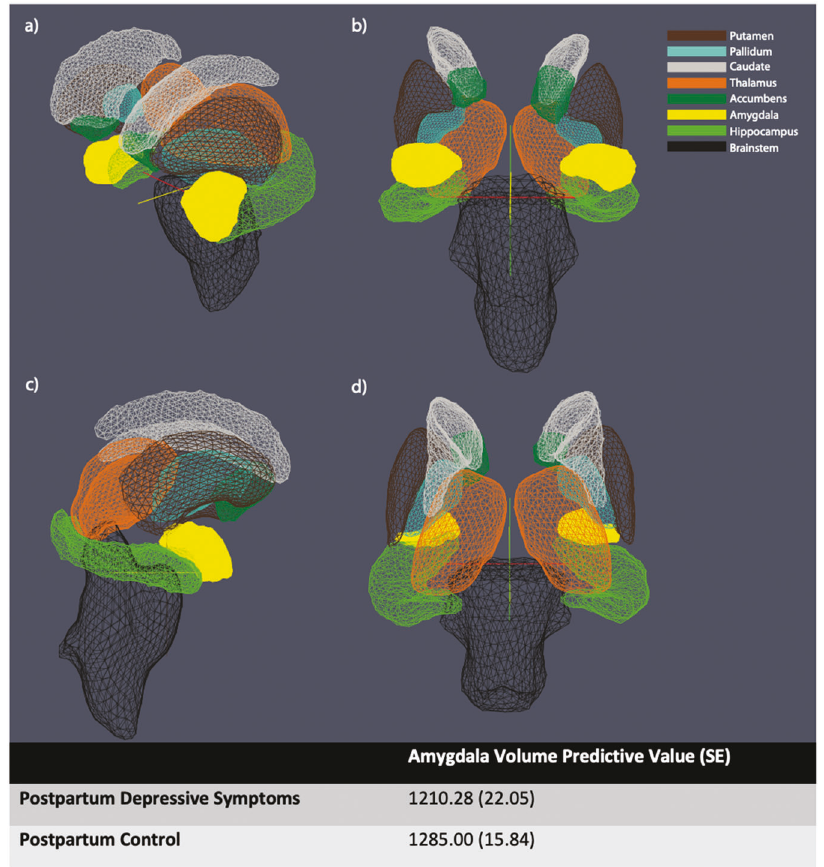
Fig. 2 Illustration of the amygdala (in yellow) relative to other subcortical structures. The amygdala using a Dorsolateral, b anterior, c lateral, and d posterior views. Note: The amygdala volume predictive values were calculated from the amygdala regression model that controls for age, sex, ICV, maternal age, maternal education, recruitment clinic, alcohol exposure in utero, smoking exposure in utero, and maternal HIV in